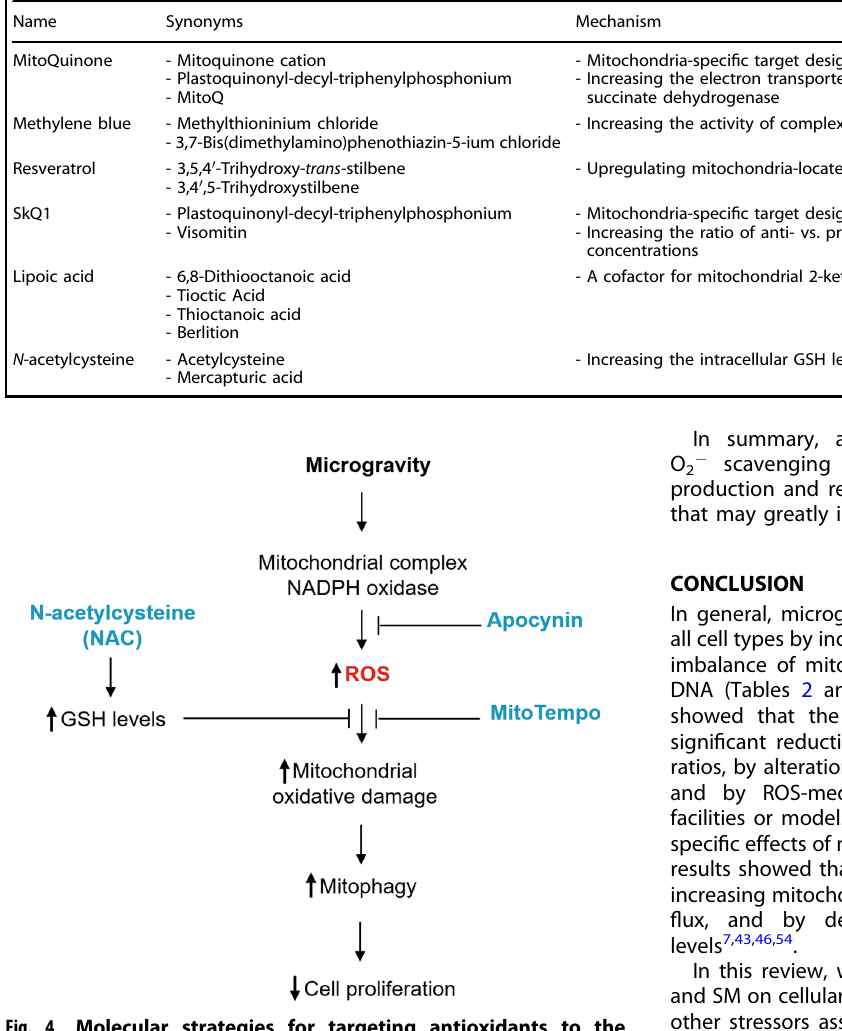
Fig. 4 Molecular strategies for targeting antioxidants to the mitochondria. MitoTempo increases mitochondrial O2 − dismuta- tion and accumulates in the mitochondria. Apocynin, an NADPH oxidase inhibitor, attenuates ROS production as well as the resultant neuroin fl ammation and mitochondrial injury. N -acetylcysteine (NAC) is an aminothiol and synthetic precursor of intracellular cysteine and GSH, and is thought to be an important